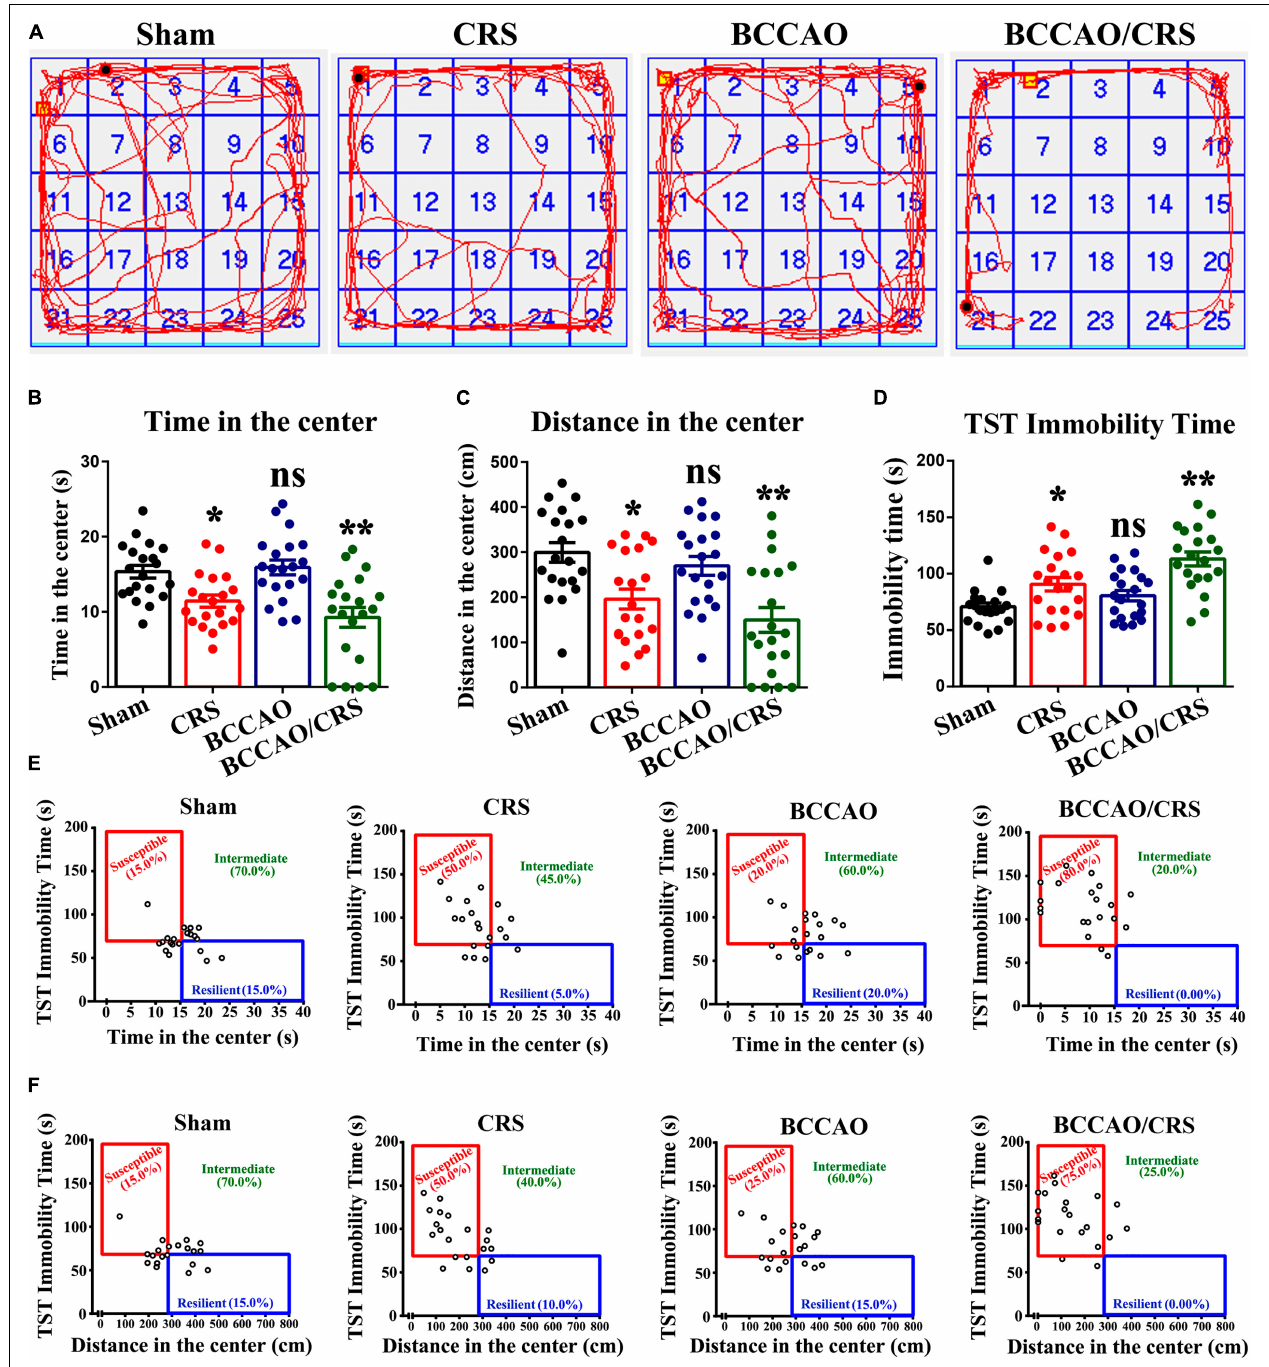
FIGURE 2 | Behavioral tests validate successful establishment of rat BPSD model with severe depression and anxiety. (A) Representational trajectories of rats moving in the open field in different groups. (B) Bar summarizing the total time of rats in the center during open field test (OFT). (C) Quantitation of the total distance of rats in the center during open field test (OFT). (D) Statistical analysis of immobility time of rats in the tail suspension test (TST). (E) The total time in the center during OFT against immobility time during TST indicating the susceptibility to depressive and anxious phenotype in various groups. A median split on both times spent in the center area (median = 15 s) and immobility time (median = 70 s) was used to separate rats into susceptible, intermediate and resilient phenotypes in different groups. (F) The distance in the center during OFT against immobility time during TST delineating the susceptibility to depressive and anxious phenotype in various groups. A median split of distance (median = 280 cm) in the center using OFT and immobility time (median = 70 s) using TST was performed to separate rats into susceptible, intermediate and resilient phenotypes in different groups. * P < 0.05, ** P < 0.01, ns P > 0.05 vs. Sham. Data are presented as mean ± SE. n = 20 in each group.